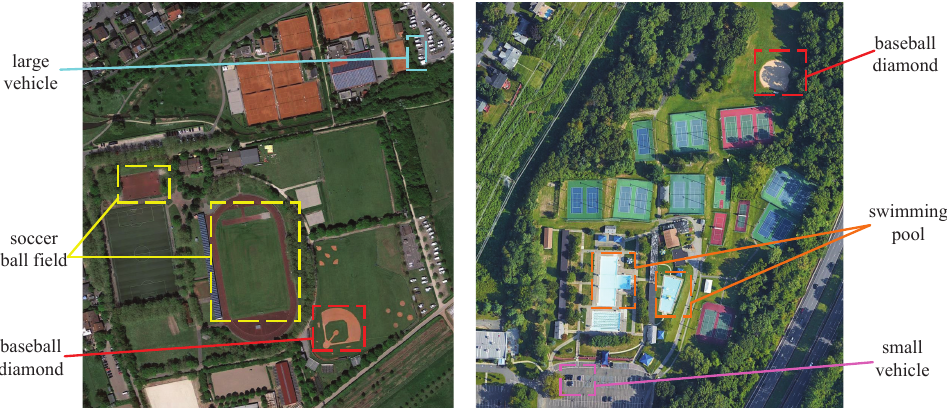
Figure 1. The challenges of semantic segmentation of very-high-resolution remote sensing